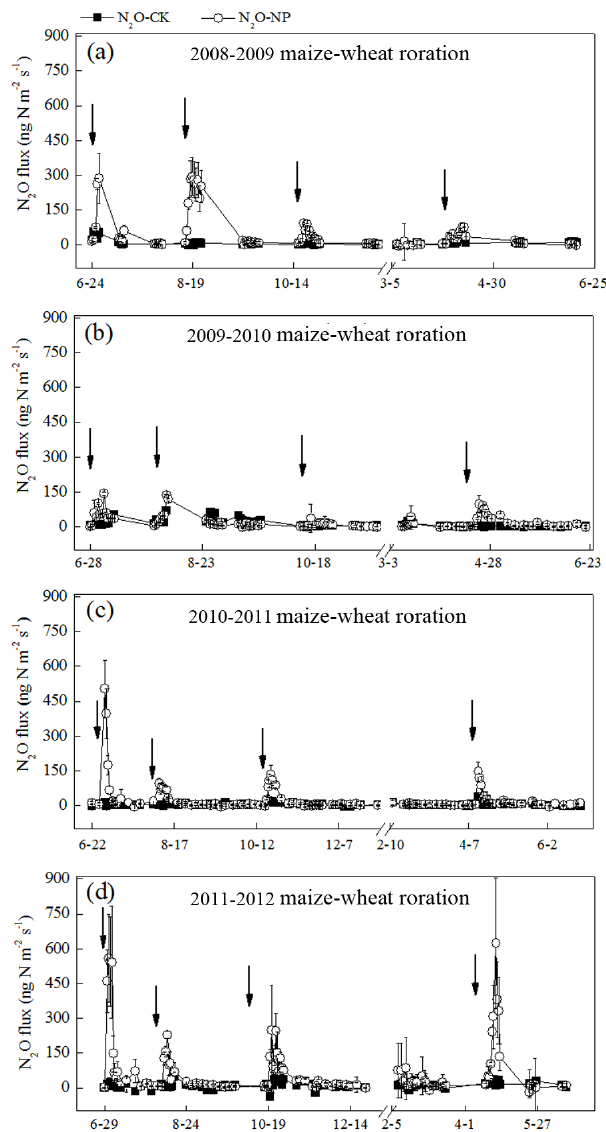
Fig. 2. N 2 O emissions from the CK and NP treatments during the N 2 O measurement periods in the 2008–2009 (a) , 2009–2010 (b) , 2010–2011 (c) and 2011–2012 (d) maize–wheat rotations. Arrows show fertilizer